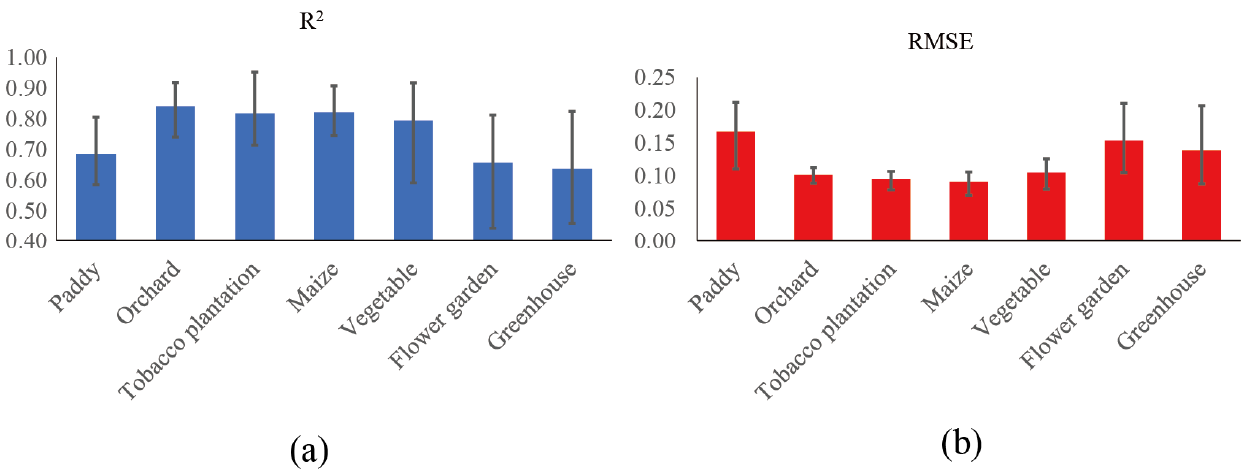
Figure 12. Class-specific evaluation result of various crop types. ( a ) The estimation result of R 2 . ( b ) The estimation result of RMSE. The evaluation result is calculated by the mean R 2 and RMSE of the cloudless target and retrieval NDVI regions of 2020 images.